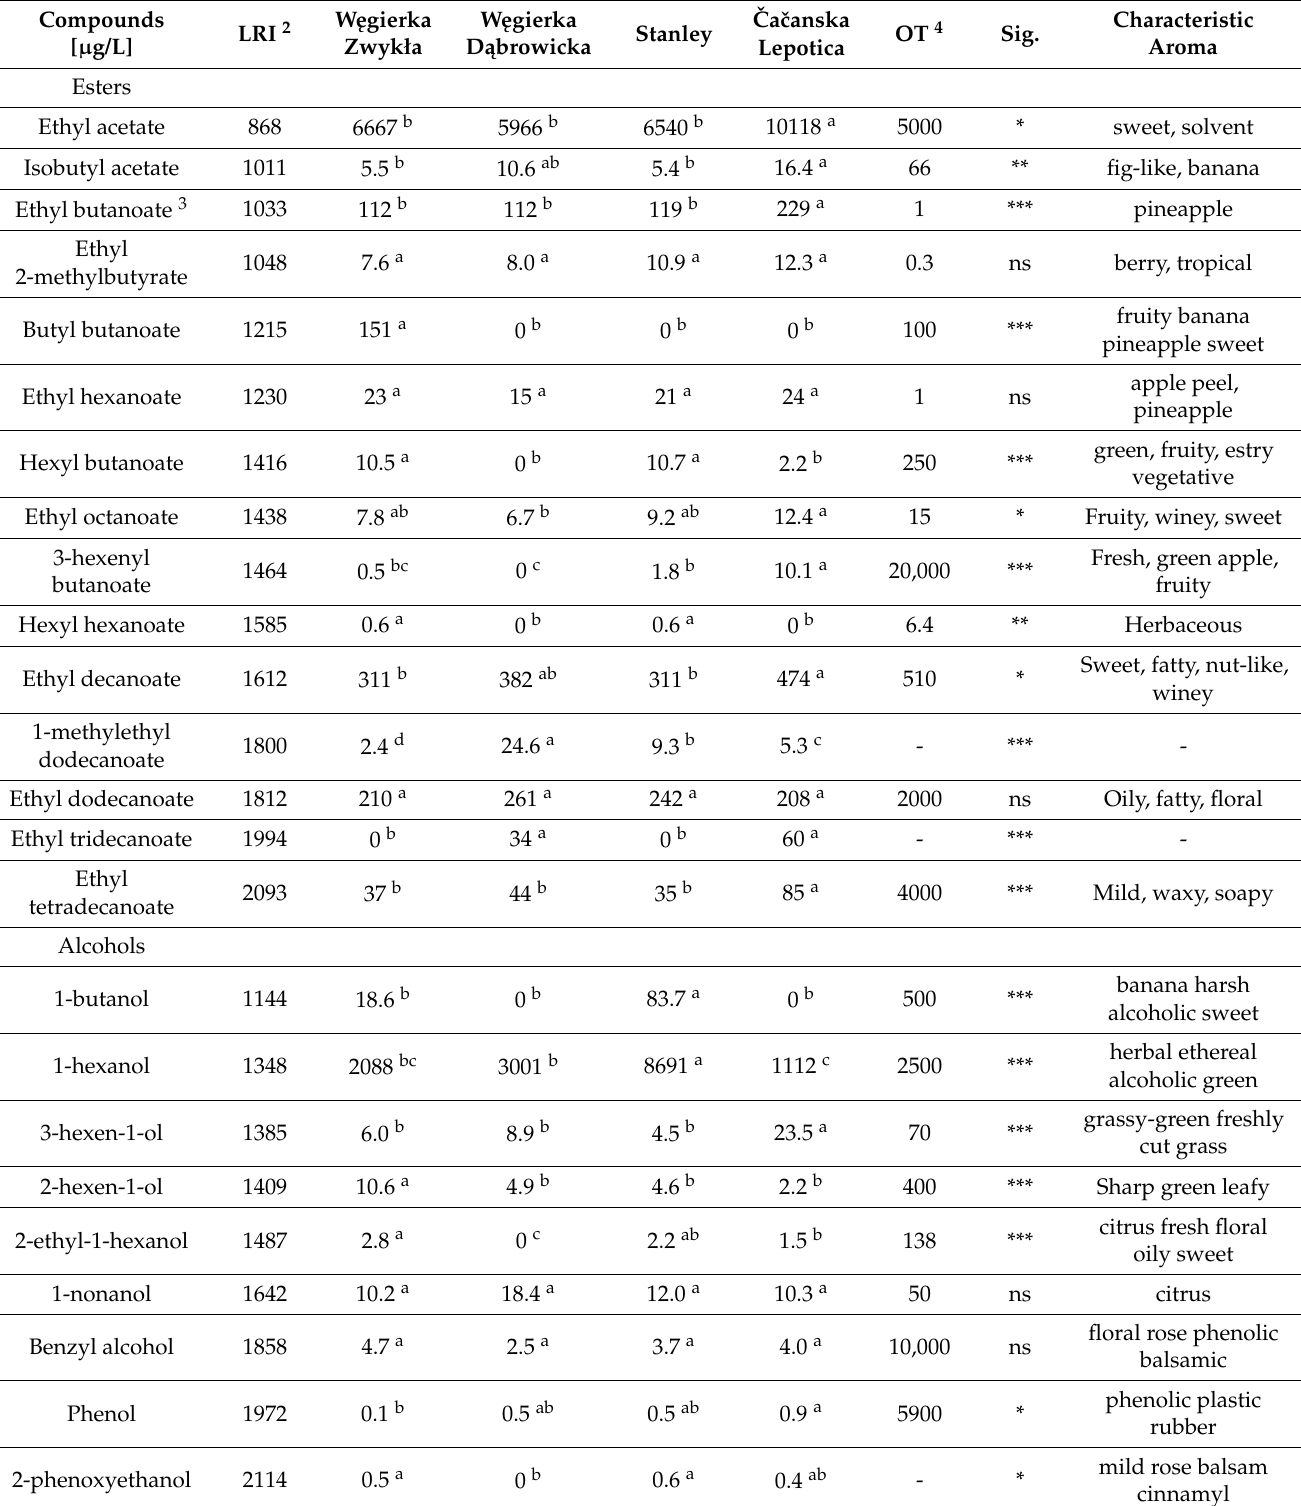
Table 4. The composition of volatile compounds in musts obtained from various plum cultivars [ µ g/L].